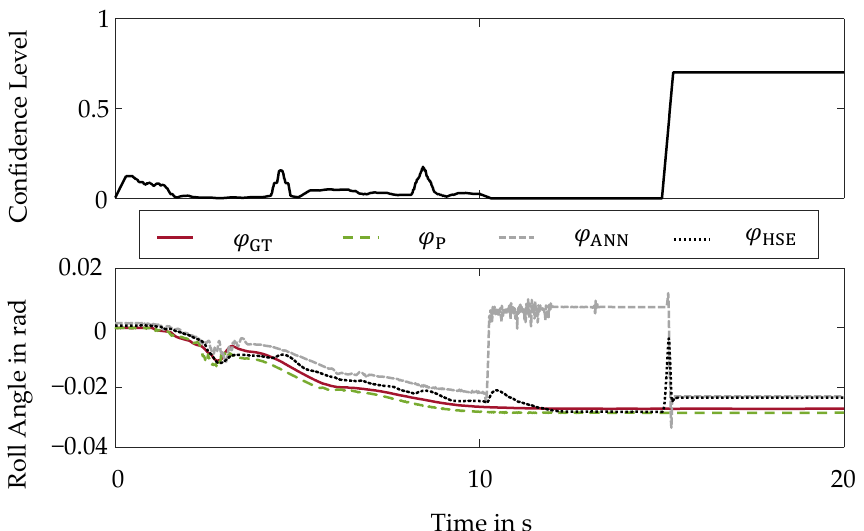
Figure 5. Hybrid Method of State Estimation-Sensor Offset: ( Top ): Confidence Level; ( Bottom ): Roll Angle Curves.